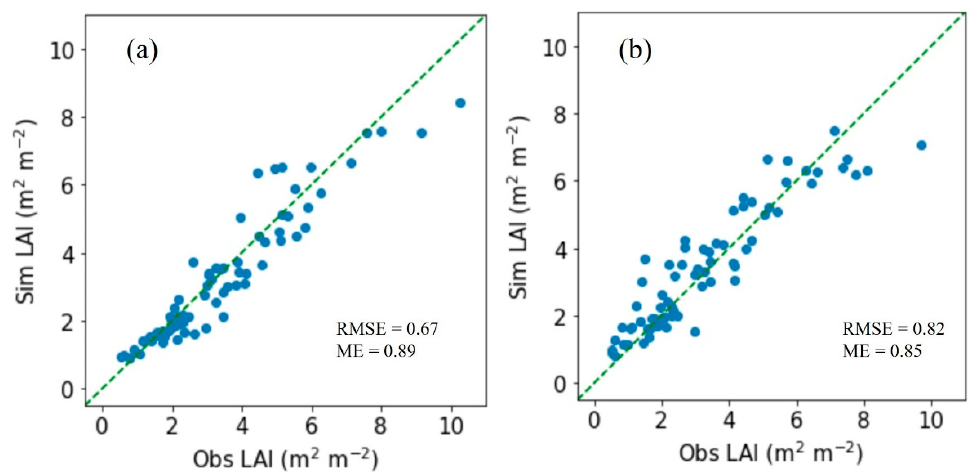
Figure 5. Comparisons between simulated (Sim) and observed (Obs) LAI values for barley by ( a ) Gradient Boost and ( b ) deep neural network (DNN) regression models. Table 3. Observed (Obs) versus simulated (Sim) LAI values of barley and wheat according to absolute mean error (MAE), root mean squared deviation (RMSD), and Nash–Sutcliffe model efficiency (ME) for the Gradient Boost (GB) and deep neural network (DNN) regression models.